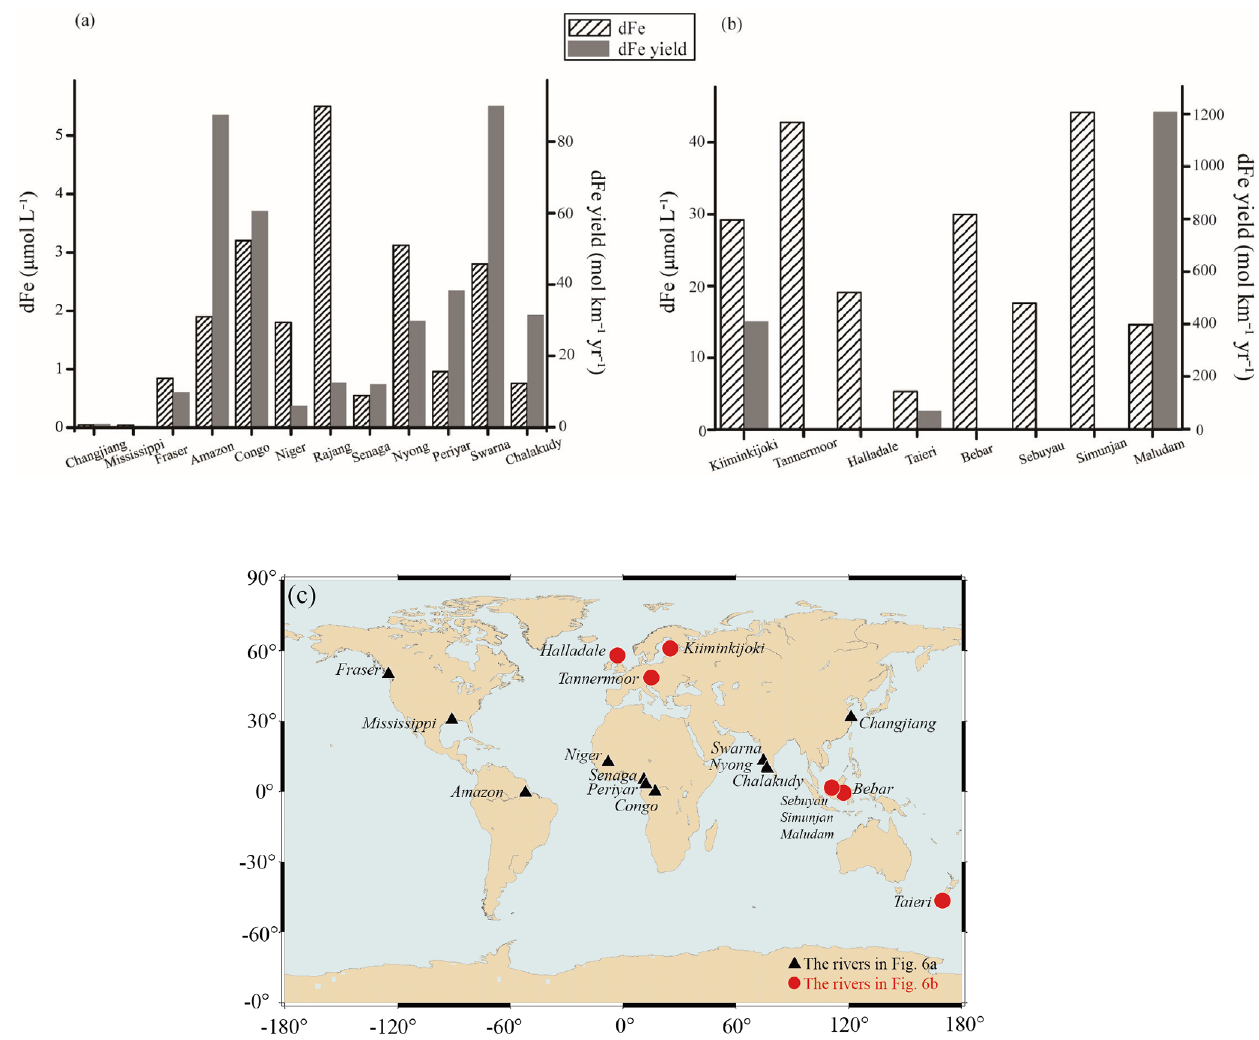
Figure 6. Concentration and yield of dFe in large rivers (a) and blackwater rivers (b) . The locations of the rivers are shown in (c) . The concentration of dFe in the Rajang is the average of dFe in freshwater river